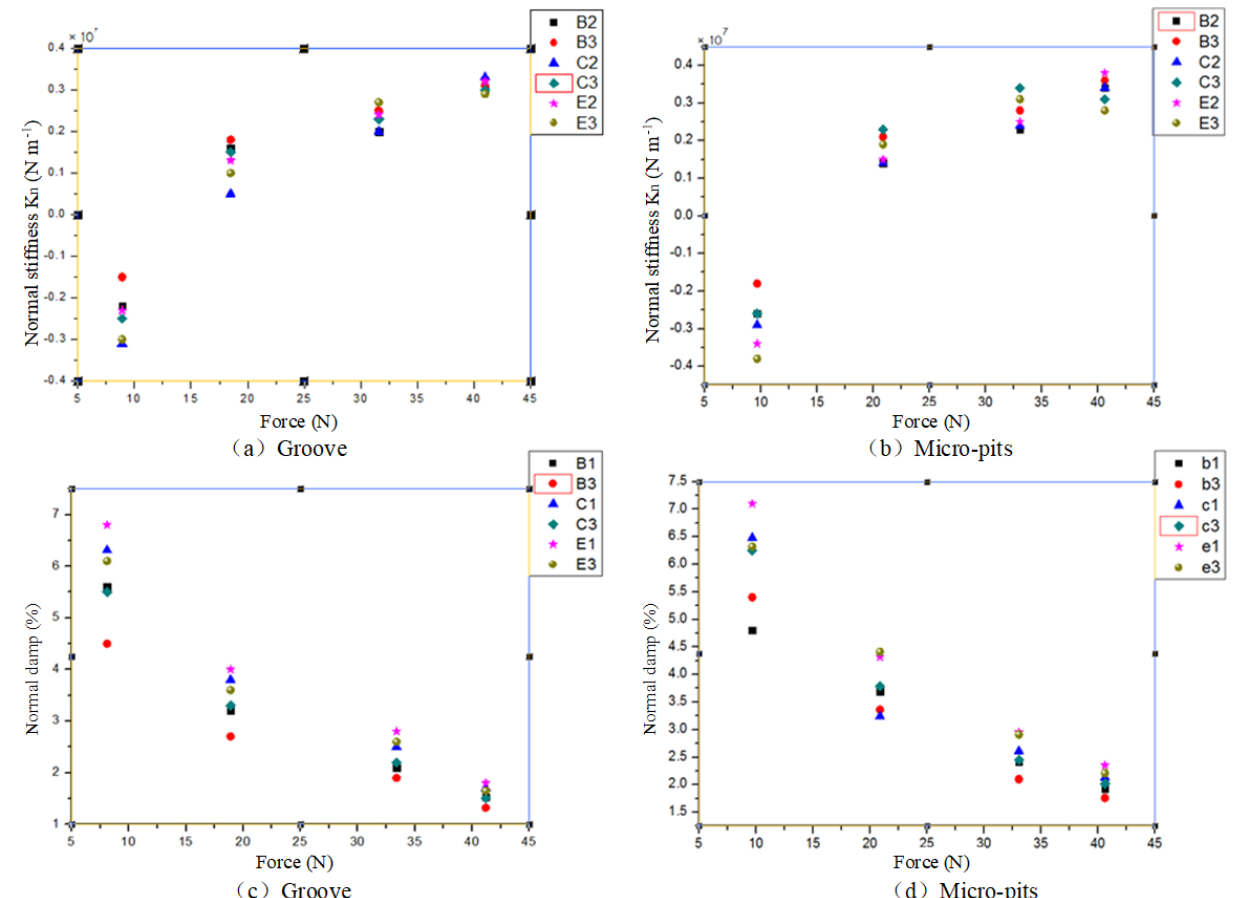
Figure 17. (a, b) The impact of texture on the normal stiffness (groove and micro-pits). (c, d) The impact of texture on the normal damp (groove and